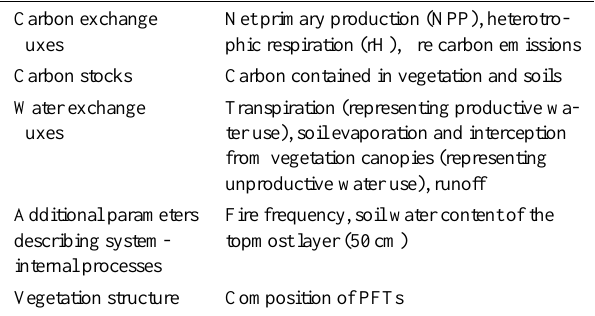
Table 1. LPJmL model outputs (aggregated to 30yr averages) used to compute present and future ecosystem states and the 0